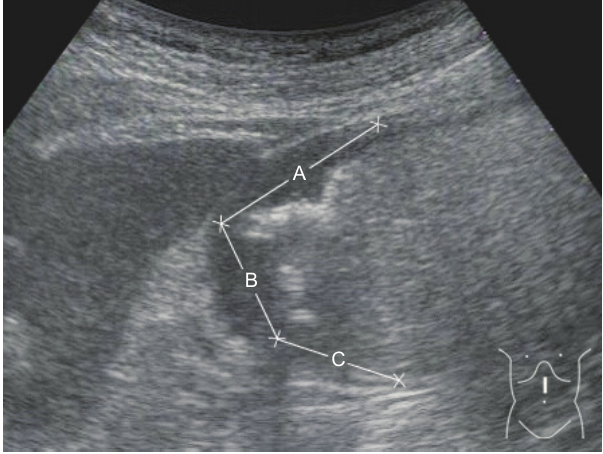
Figure 19 Segmented measurement of upper and lower diameter of gastric wall lesion (upper and lower diameter of lesion = A + B +